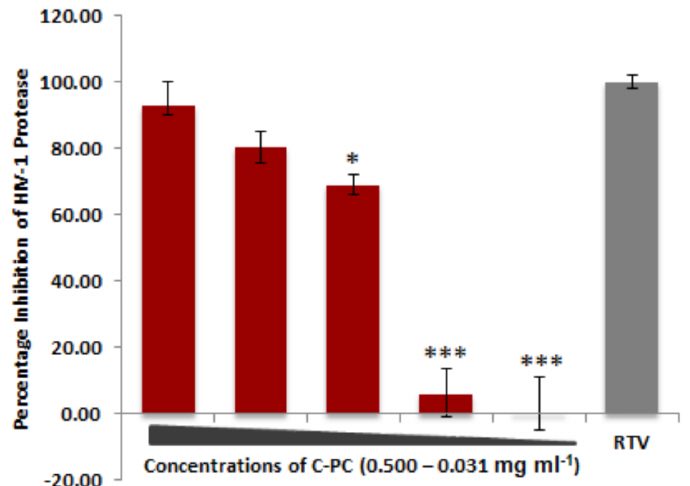
Figure 6. C-PC inhibits HIV-1 protease enzyme. The percentage inhibition of HIV-1 protease enzyme activity in the presence of C-PC in a dose-dependent (0.50–0.31 mg/mL) analysis compared to the known HIV-1 PR inhibitor RTV (10 µ M). * p < 0.05 and *** p <